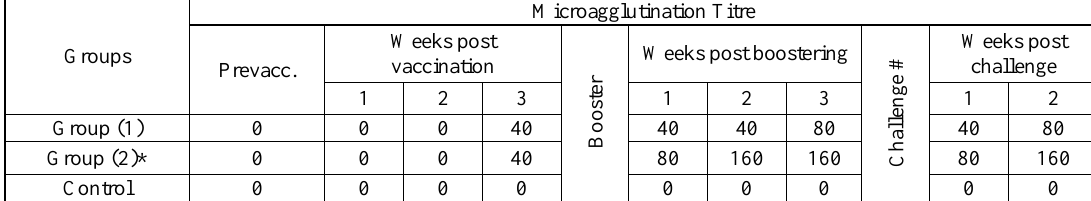
Table 1: Microagglutination titer in sera of vaccinated turkey poults using O1 antigen and challenged with E.coli serotype O1: